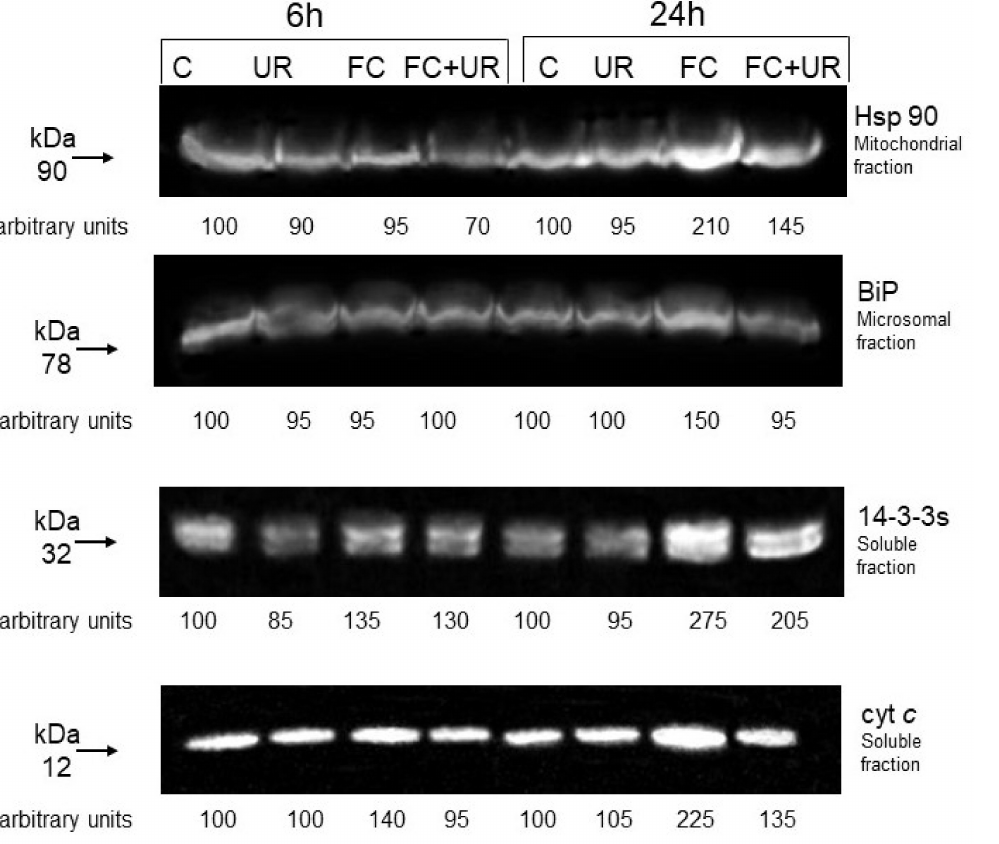
Figure 7. Effect of FC and urate on the levels of stress-related proteins. C, control; UR, cells + 1 mM urate; FC, cells treated with 20 µ M FC; FC + UR, cells treated with 20 µ M FC + 1 mM UR. Image and densitometric results of a typical experiment are presented. Fifty milligrams of proteins were run in each lane. At each experimental time, an arbitrary value of 100 was assigned to the quantity of immunodecorated protein of the controls. The experiment was repeated three times in duplicate. The variability did not exceed